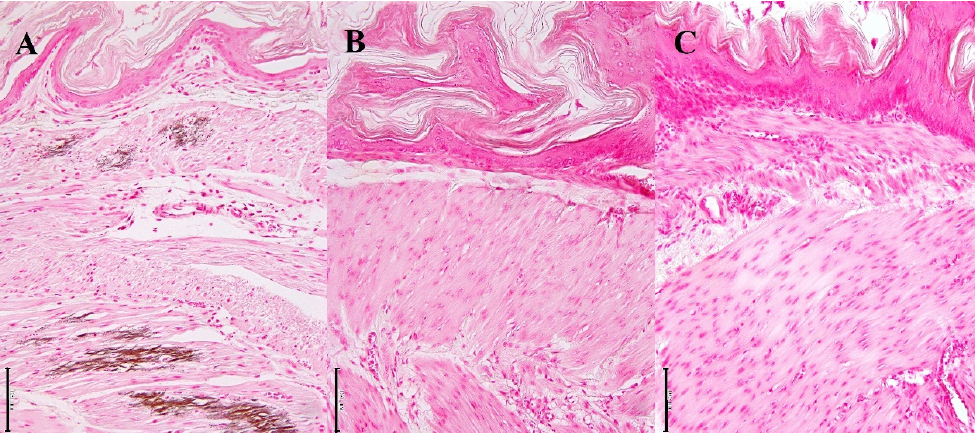
Figure 7. Histopathological changes in the gastric mucosa. ( A ) Vit D 3 -treated mice. Calcification is seen in the gastric mucosa. von Kossa stain. Bar = 100 µ m. ( B ) Vit D 3 + SEF-treated mice. Calcification is not found. von Kossa stain. Bar = 100 μ m. ( C ) Untreated mice. von Kossa stain. Bar = 100 μ m.